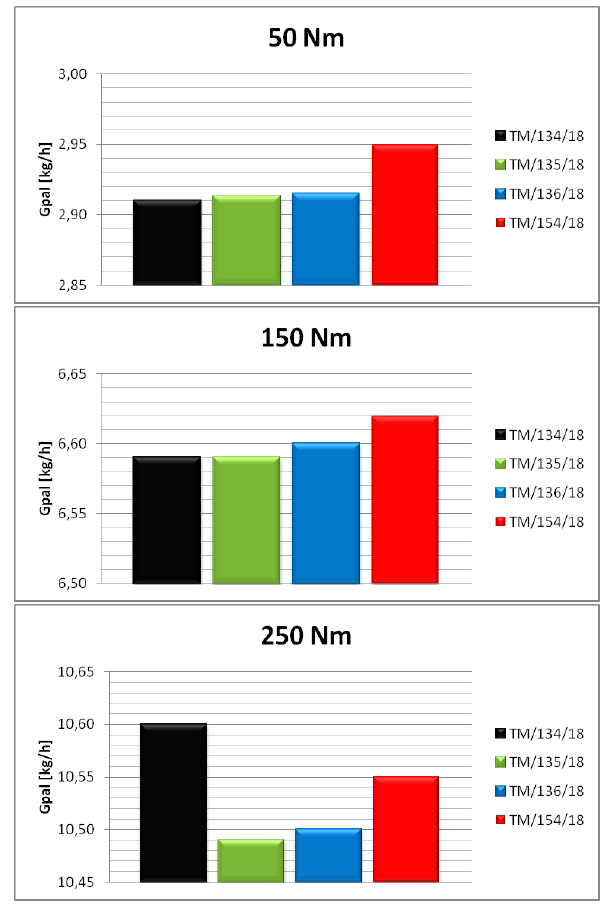
Fig. 1. Hourly fuel consumption in selected duty points of the engine for the four tested